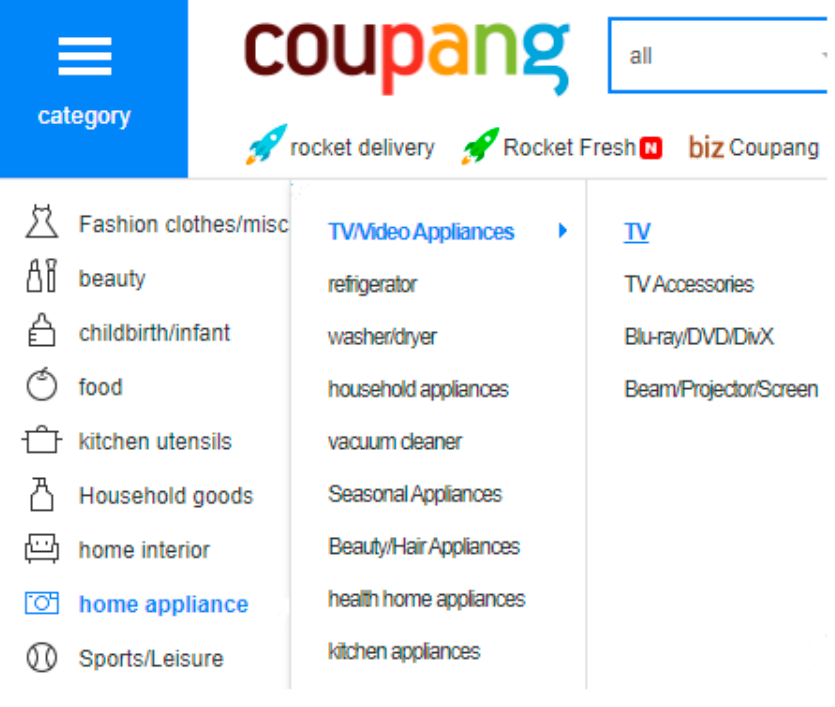
Figure 5. Coupang product categories.